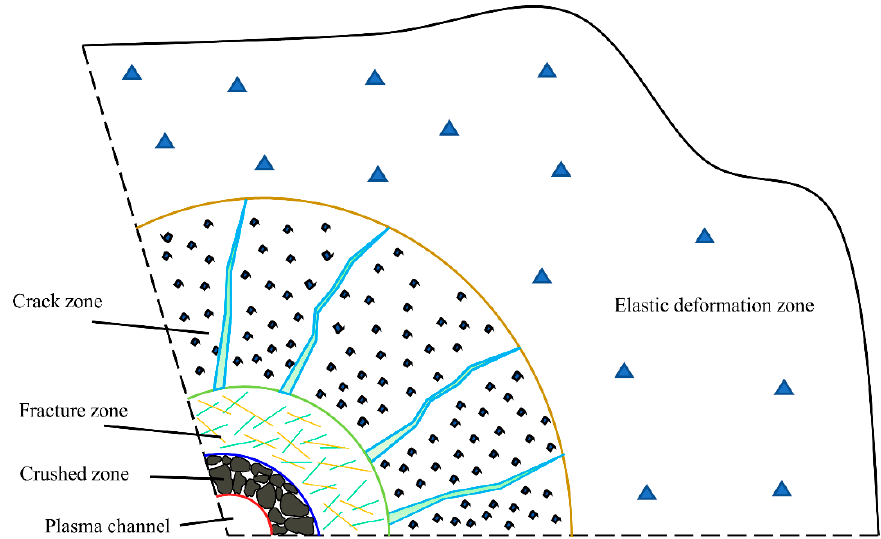
Figure 7. Schematic diagram of damage partitioning of rock electrical pulses.